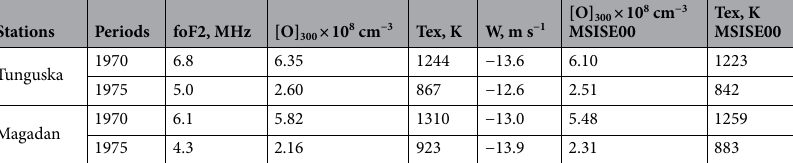
Table 2. Ionospheric and thermospheric parameters inside (Magadan) and outside (Tunguska) the anomaly area in June under maximum (1970) and minimum (1975) solar activity. MSISE00 model values are given for a